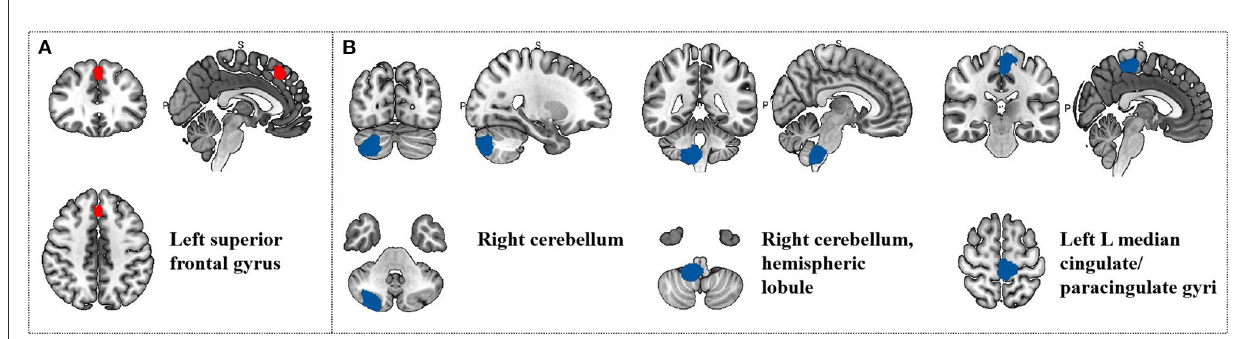
FIGURE7 Results of Meta-regression linear model analysis. (A) Head frequency of migraine patients are positive correlated with regional activity in the Left superior frontal gyrus. (B) Head frequency of migraine patients are negative correlated with regional activity in the Right cerebellum, the Right cerebellum, hemispheric lobule and the Left median cingulate/paracingulate